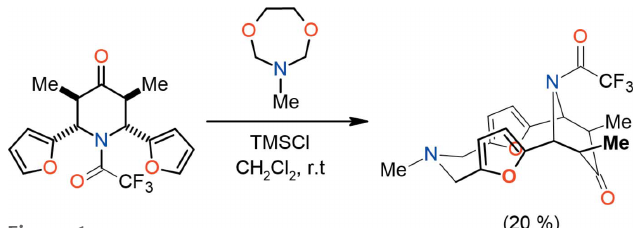
Figure 1 The synthetic route.